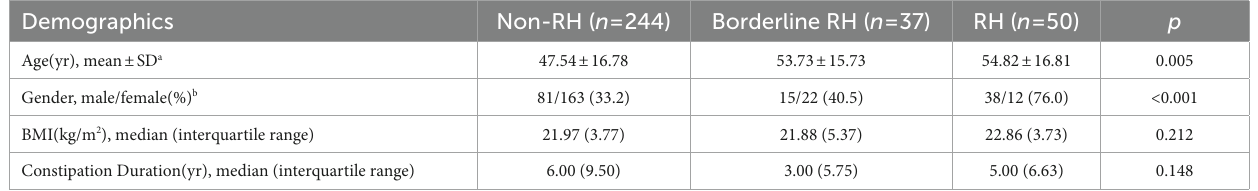
BMI: body mass index; yr: year. a The patients in RH and Borderline RH groups were significantly older than those in Non-RH group (post hoc p = 0.005 and p = 0.036, respectively).